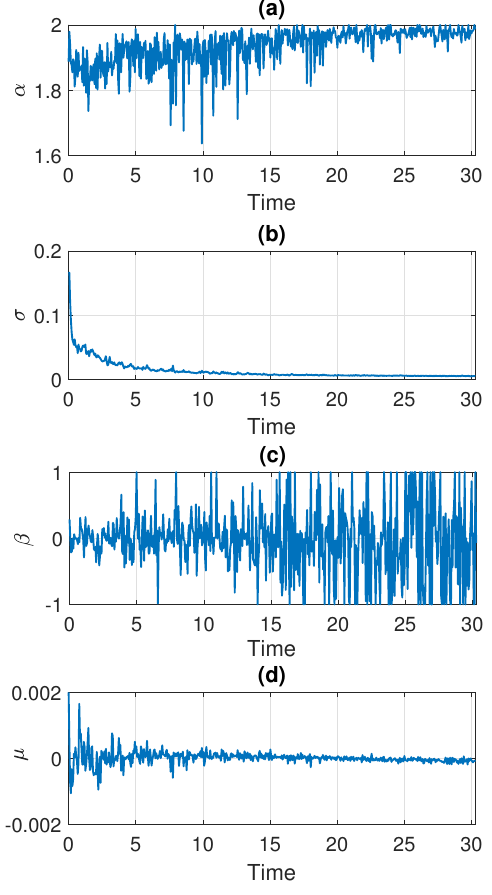
Figure 6. Estimated parameters of the stable distribution for Signal